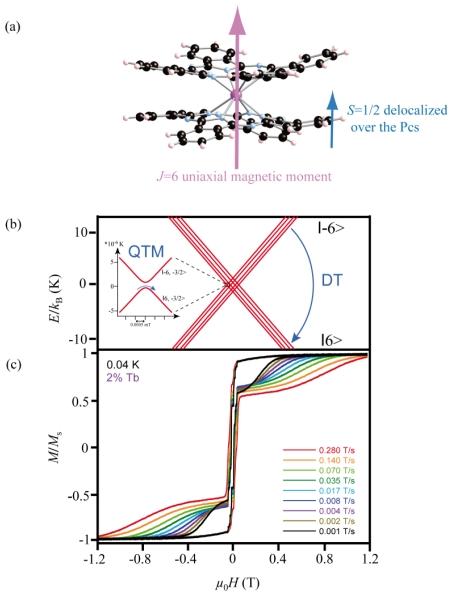
Magnetization reversal mechanisms in the TbPc2 SMM (alkyl and pyrene substituents are omitted for reasons of clarity). (a) Scheme of the TbPc2-SMM. The terbium ion has a J = 6 magnetic moment and an unpaired electron is delocalized over the organic part; (b) Zeeman diagram calculated for the TbPc2 SMM ground state (J = 6, |Jz| = 6). The interaction with the Tb nucleus spin I = 3/2 splits each electronic substate through the hyperfine coupling, providing a path for Quantum Tunneling of Magnetization (QTM) at the anti-crossing of two levels; (c) Hysteresis loops of the crystallized TbPc2-SMM (2% in the YPc2 matrix) measured at 40 mK for different sweeping rates ranging from 1 to 280 mT.s−1. QTM reflects in staircase-like steps of the hysteresis loops at low magnetic fields, each step corresponding to a level anti-crossing. Molecules, which did not undergo QTM can relax their magnetization to a lower energy state by the direct transition (DT) occurring at larger magnetic fields.